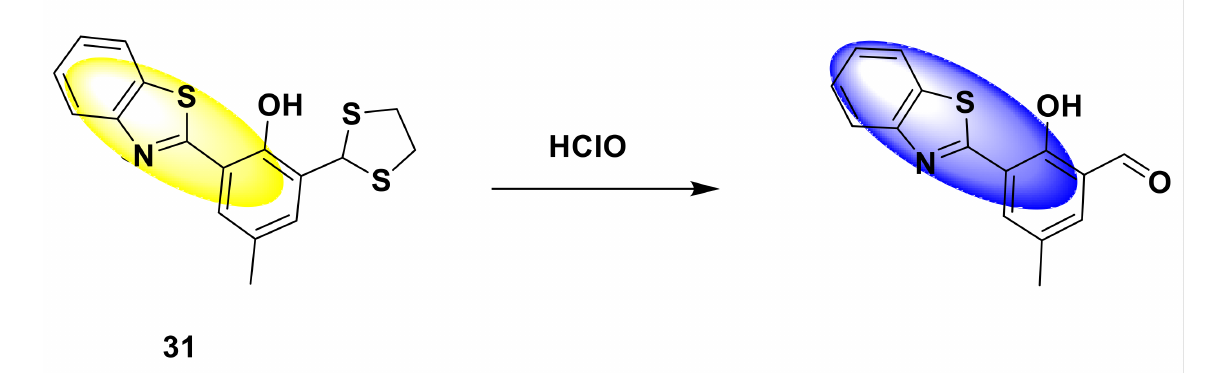
Figure 31. The reaction of probe 31 and HClO.